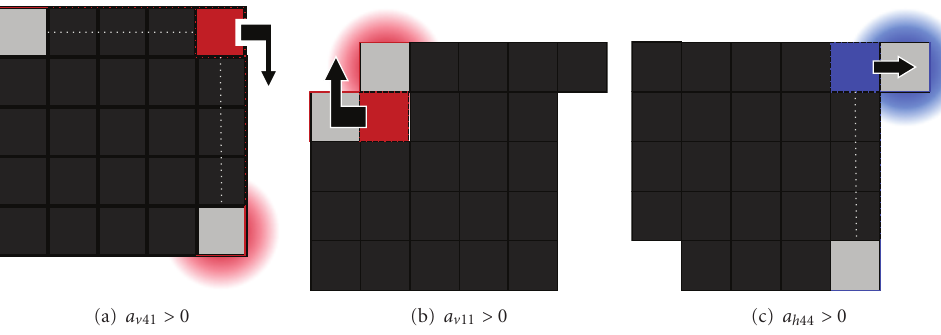
Figure 10: Transformation modes for cantilever